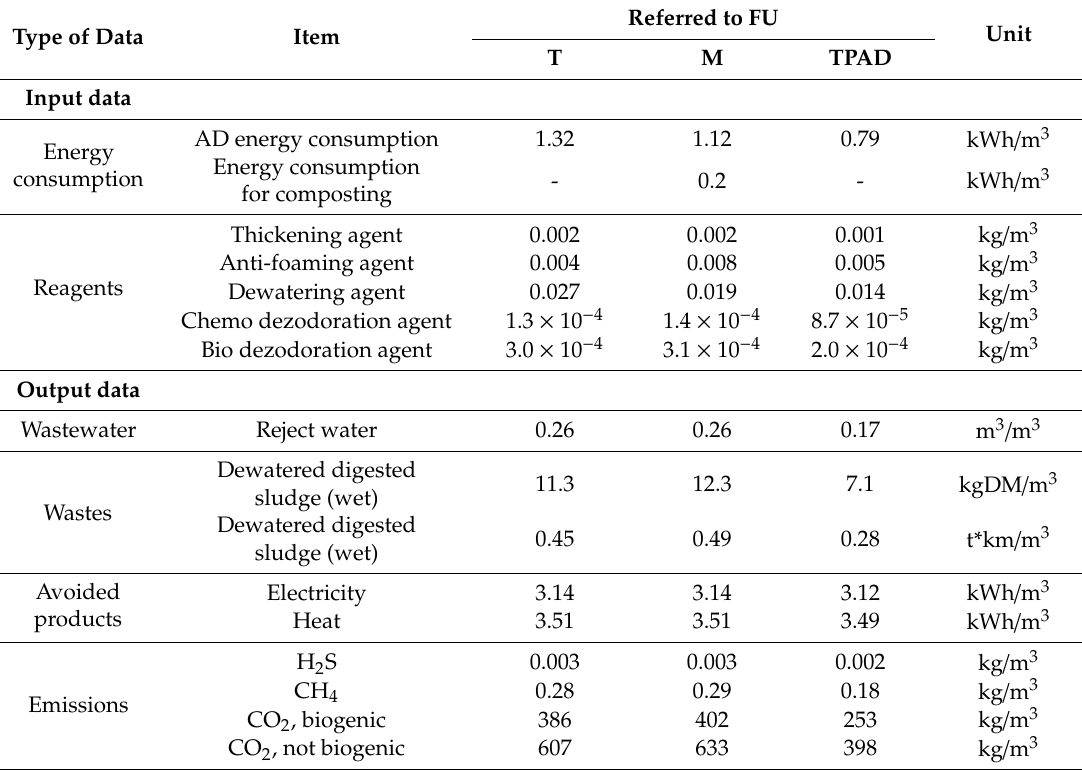
Table 3. Inventory data for the sludge line LCA (FU: 1 m 3 of produced methane). Type of